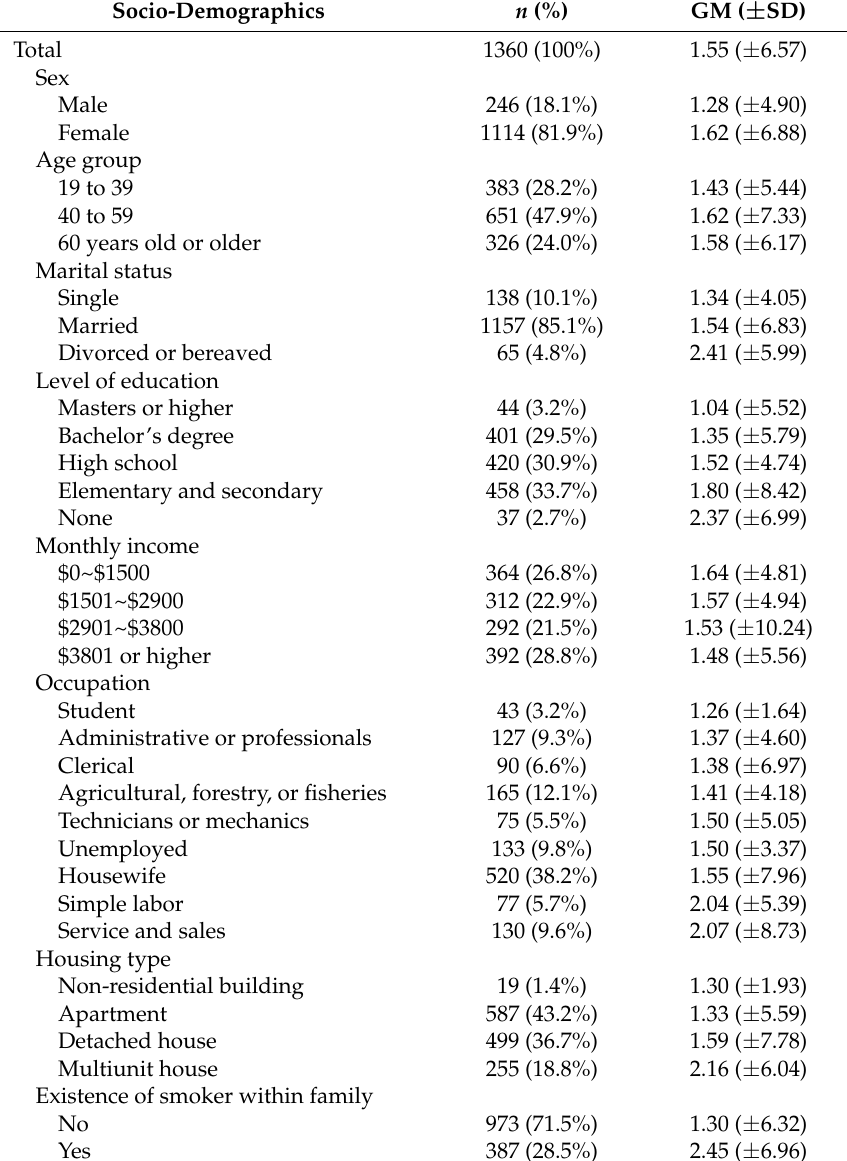
Table 1. Distributions of socio-demographic factors and their associations with creatinine-adjusted urinary cotinine concentrations (ng/mg